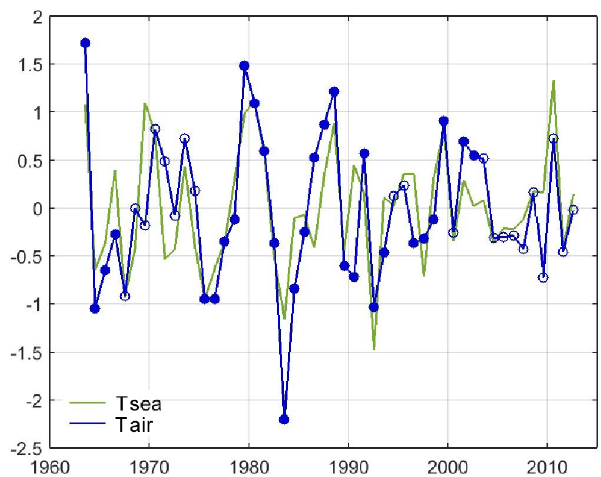
Figure 22. Normalized air temperature at 1000mbar (green) and 0– 100m sea temperature (blue) in the Red Sea. A high-pass filter has been applied to remove multidecadal variations. Solid dots indicate an averaged formal error below 0.15 ◦